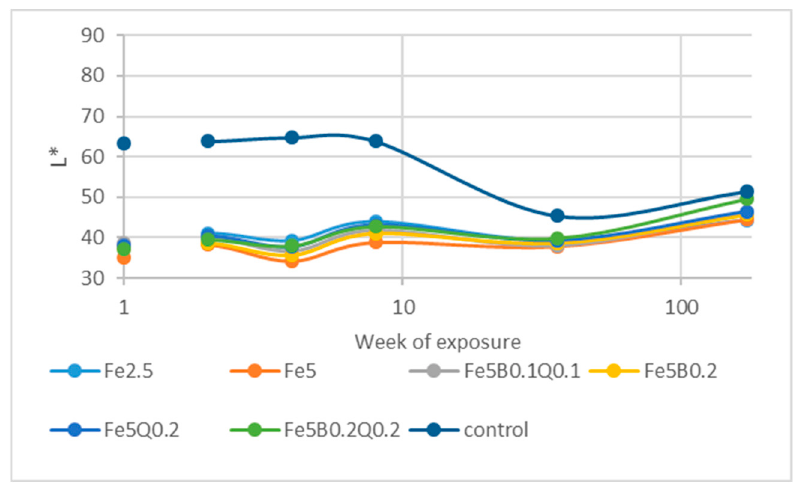
Figure 3. Mean L* values of control and treated Siberian larch samples following outdoor exposure. The compositions of treatments are presented in Table 1. The x -axis is a logarithmic scale.